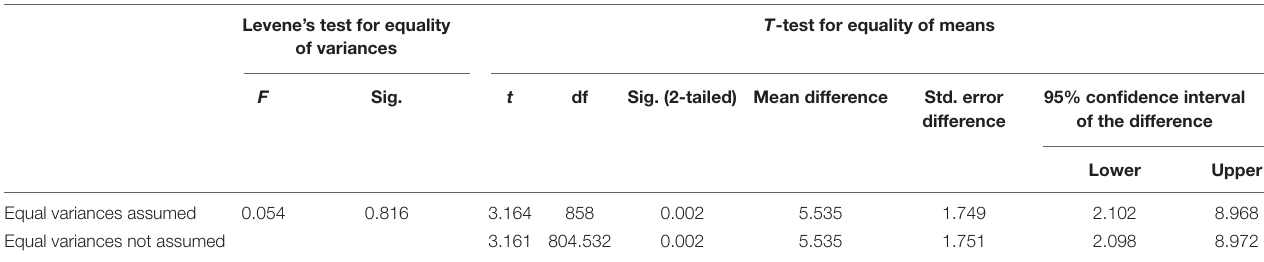
T -test for equality of means